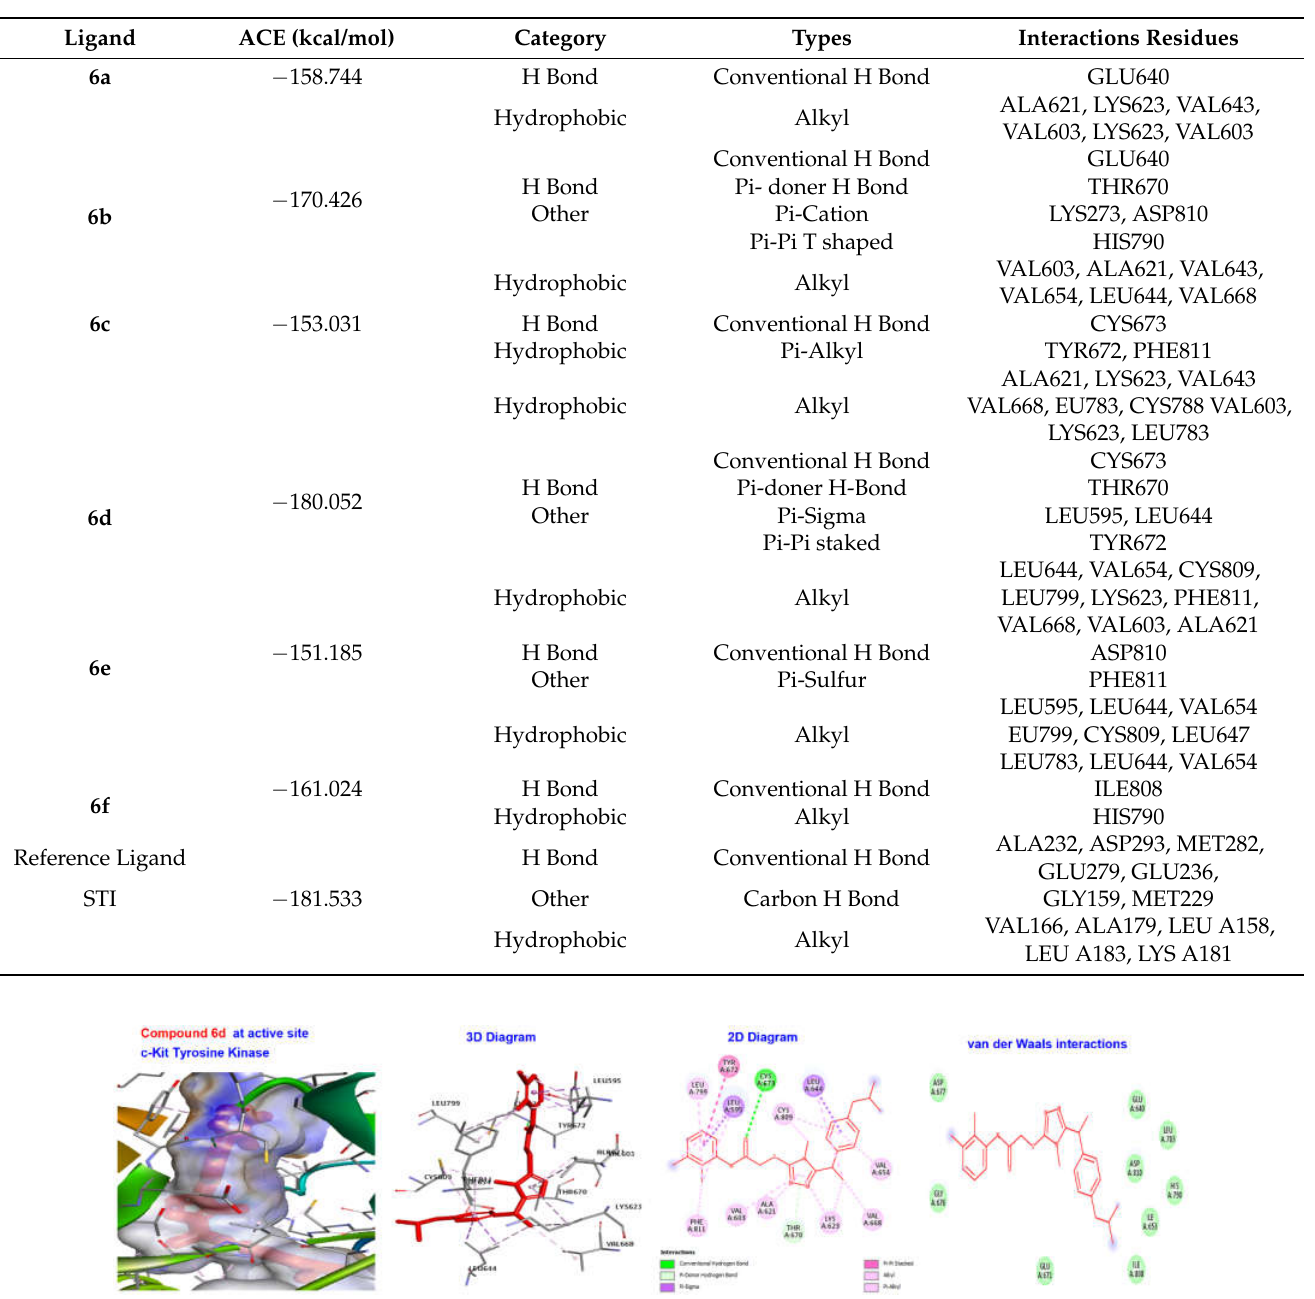
Table 5. Docking of compounds 6a–6f to Protein c-Kit Tyrosine Kinase binding pocket (PDB ID: IT46).